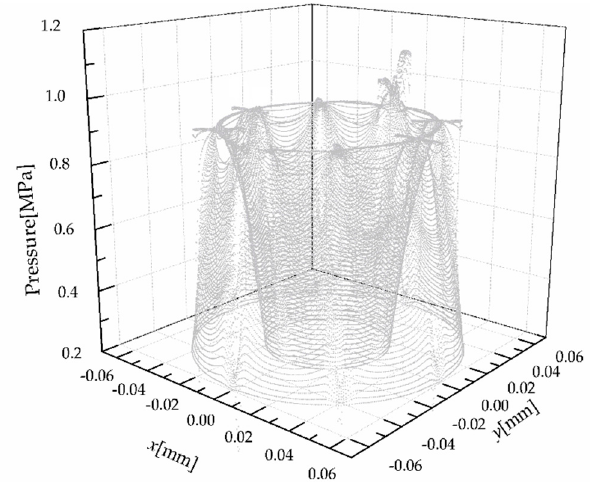
Figure 11. 3D pressure distribution in the lubrication film of the HTB.